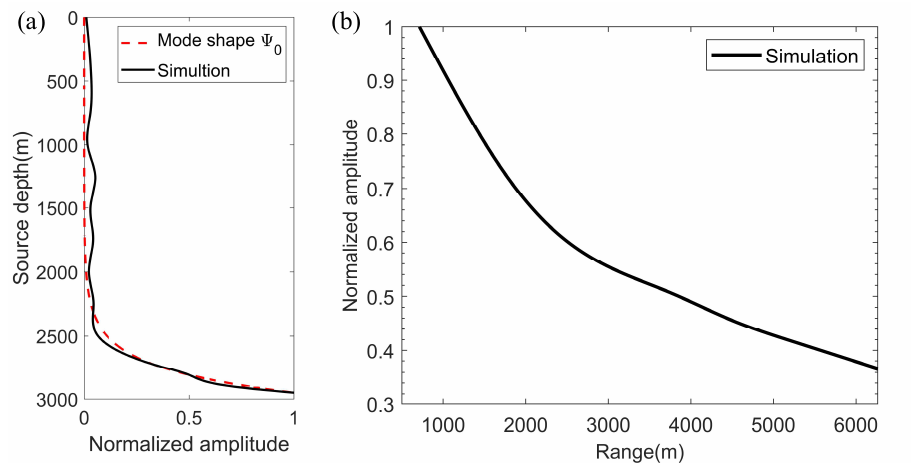
Figure 3. ( a ) Scholte wave amplitude versus source depth. The red dotted line is the mode shape for the Scholte wave and the black line is the simulation result. ( b ) Scholte wave amplitude versus propagation